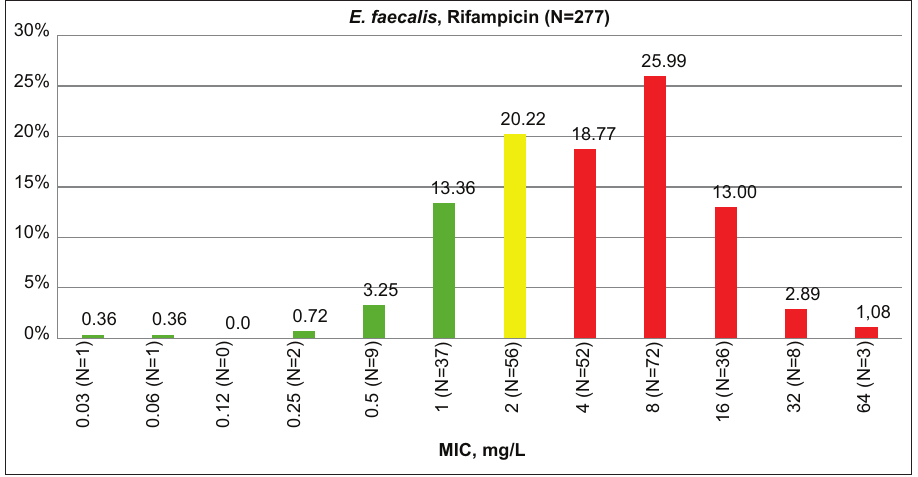
Figure-3: Rifampicin minimum inhibitory concentration distribution among Enterococcus faecalis isolates. Green columns – percent of susceptible isolates, yellow – intermediate resistant, red – resistant (CLSI 2021 breakpoints), N – number of